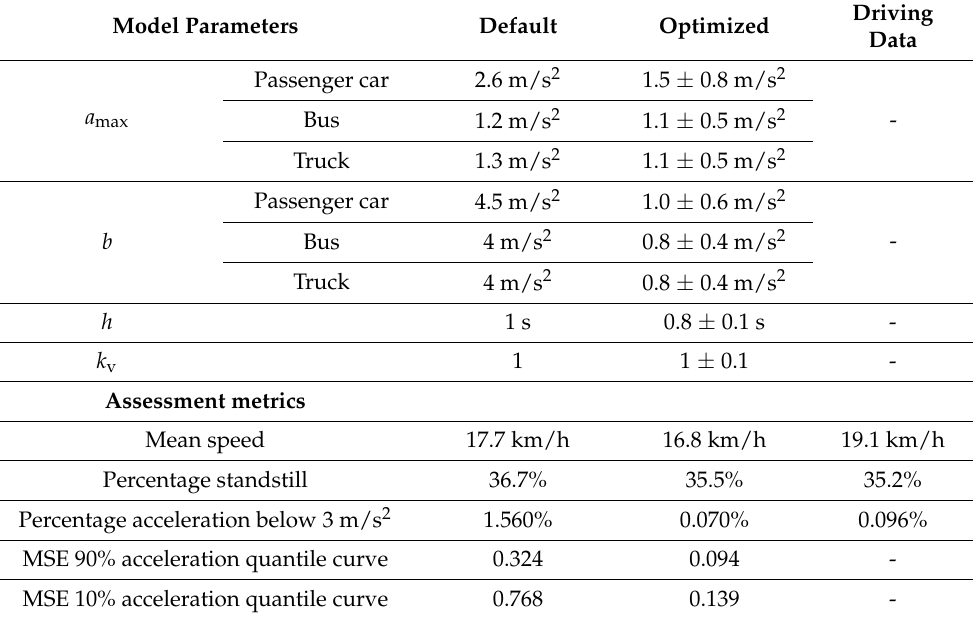
Table 1. Comparison of the EIDM model parameters and statistical assessment metrics of the resulting driving profiles. The parameters in the default SUMO parametrization are scalar values while the optimized parameters are drawn from normal distributions with given means and standard deviations.